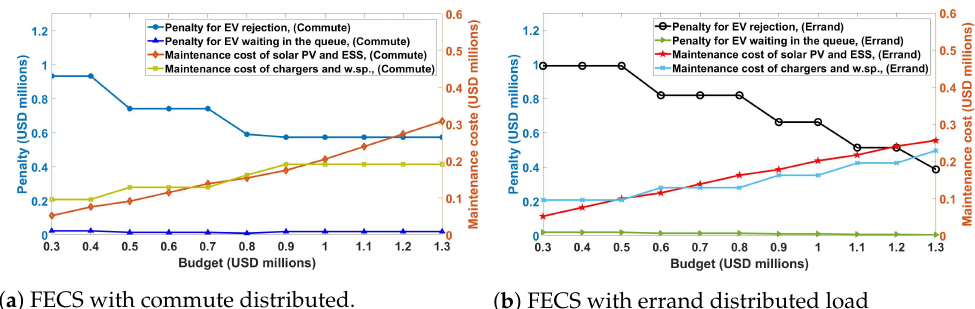
Figure 6. FECS maintenance cost and penalties according to the